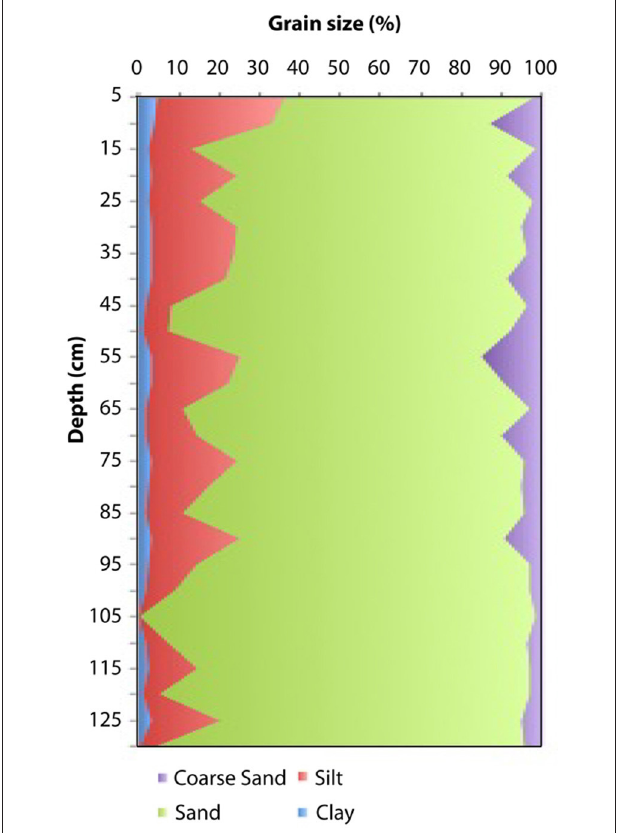
FIGURE 4 | Distribution of grain size in core CAN-N-01 profile.